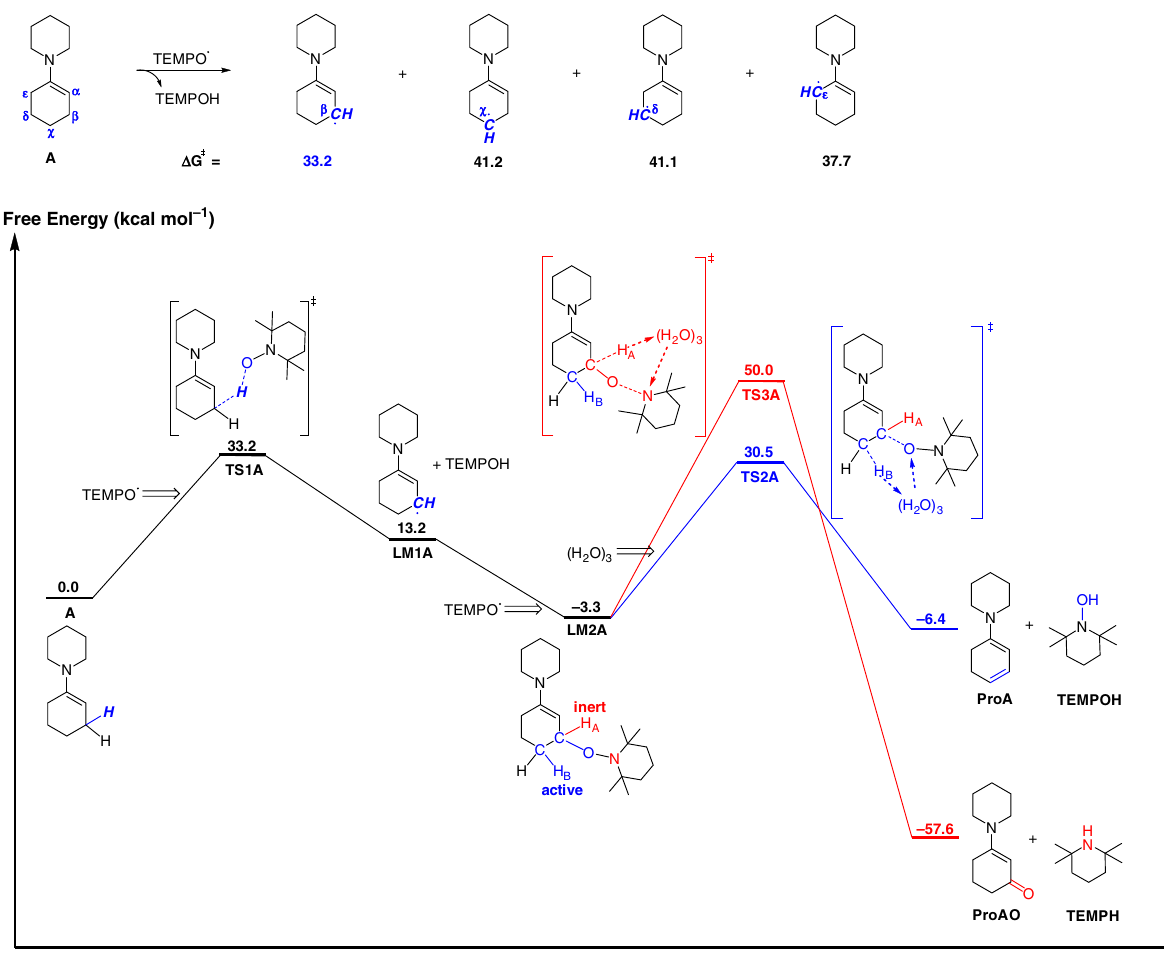
Fig. 6 Computational investigation on the mechanism for oxidation of enamine by TEMPO. Numbers are Gibbs free energies (kcal mol -1 ) with respect to the enamine reagent A and TEMPO. a Activation free energies of the hydrogen abstraction of enamine molecule A by TEMPO in different reactive sites. b Free energy pro fi les for oxidation of enamine molecule A by TEMPO. The pathway for the elimination of H B /TEMPO is shown in blue line and the pathway for the elimination of H A /piperdine is shown in red